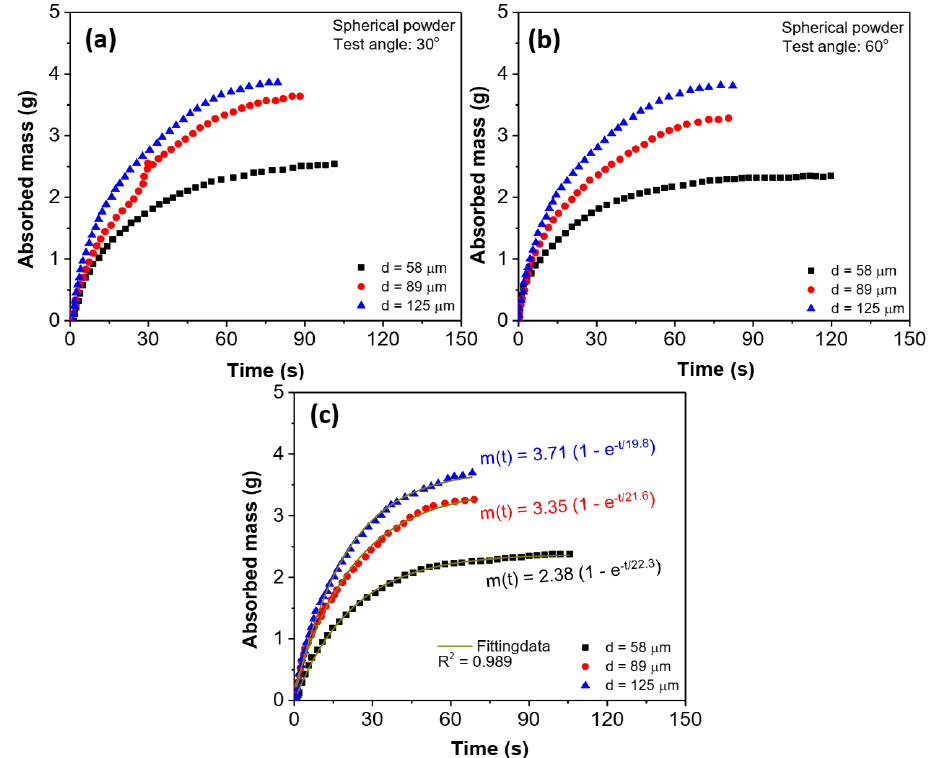
Figure 10. Amount of absorbed water of porous copper samples using spherical powder at three different angle positions ( a ) 30°, ( b ) 60°, and ( c ) 90° with predicted results.